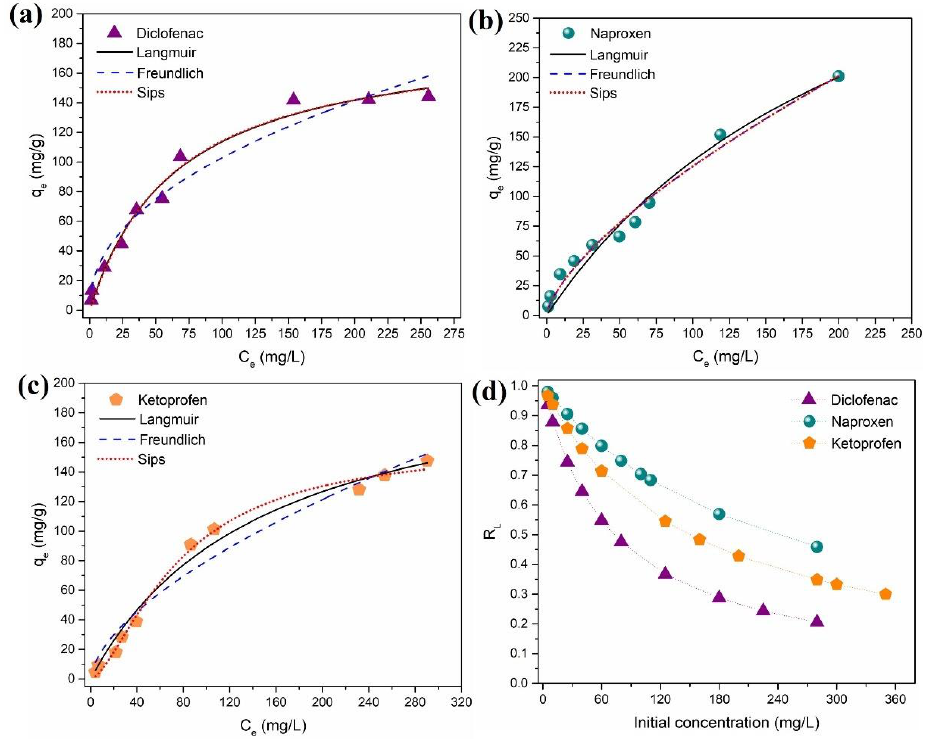
Figure 6. Isotherm data for the adsorption of ( a ) diclofenac, ( b ) naproxen, and ( c ) ketoprofen on the Fe 3 O 4 @SiO 2 /TMC/GPTMS particles and model fitting, and ( d ) R L values for DCF, NAP, and KET as a function of initial sorbate concentration.